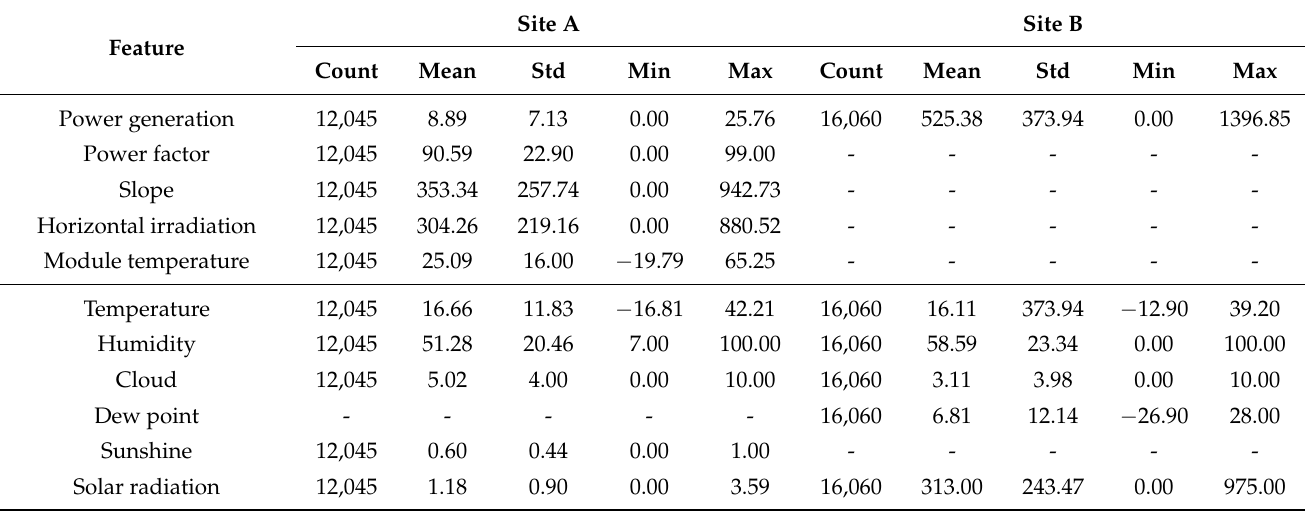
Table 3. Five statistical indices of the datasets.